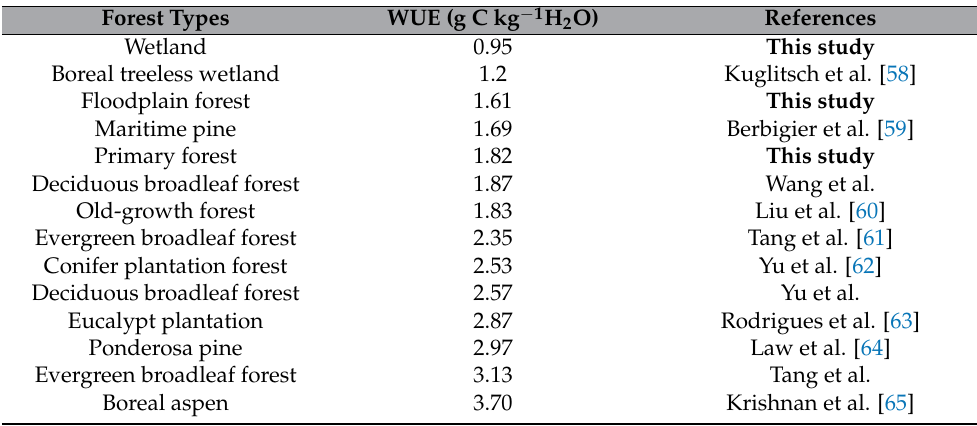
Figure 11. Monthly WUE (gC kg H 2 O day − 1 ) boxplot for each site and studied period: (Amazonia: 2009 − 2011; Caatinga: 01/2014 − 07/2015; Cerrado: 2004 − 2006; Pantanal: 2015 − 2016). Table 2. Comparison between mean annual WUE retrieved in the present study with values for different types of forests found in the